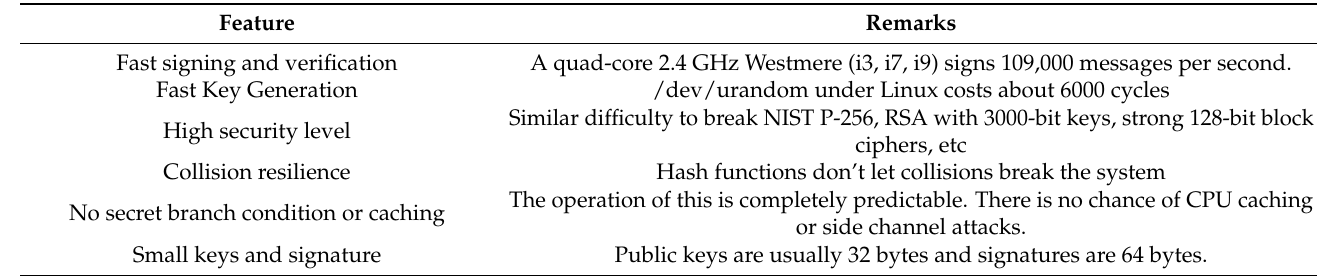
Table 7. Some notable Ed25519